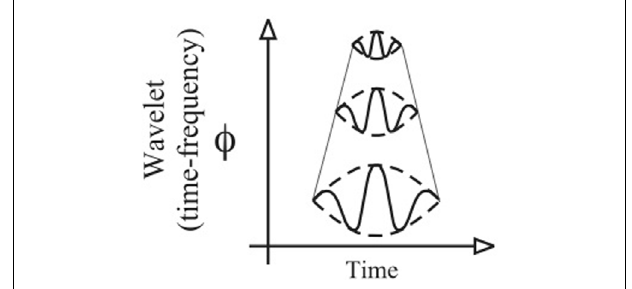
FIGURE 2 | Representation of the contraction/dilatation of the analyzing function in the time-frequency